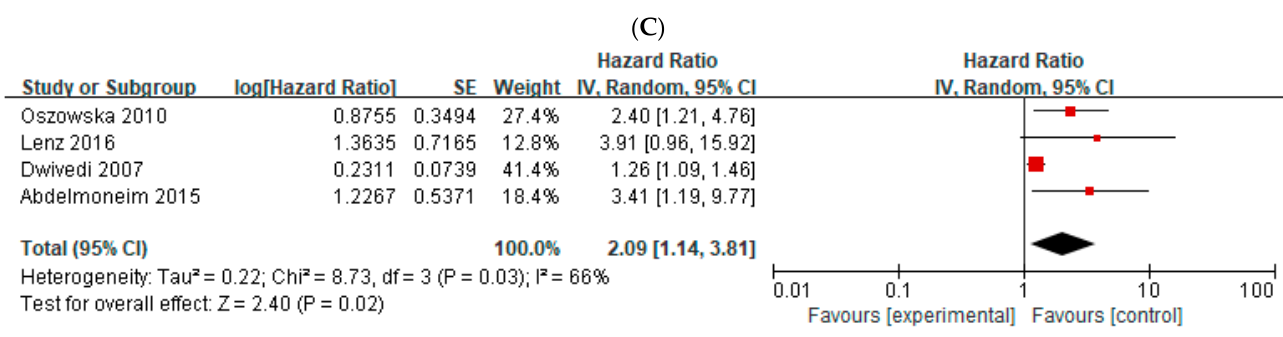
Figure 3. Forest plots of the pooled relative risks (RR) for ( A ) total cardiac events and ( B ) cardiac death, and ( C ) forest plot of pooled hazard ratios (HR) in patients after acute myocardial infarction [12–14,17,21,22].